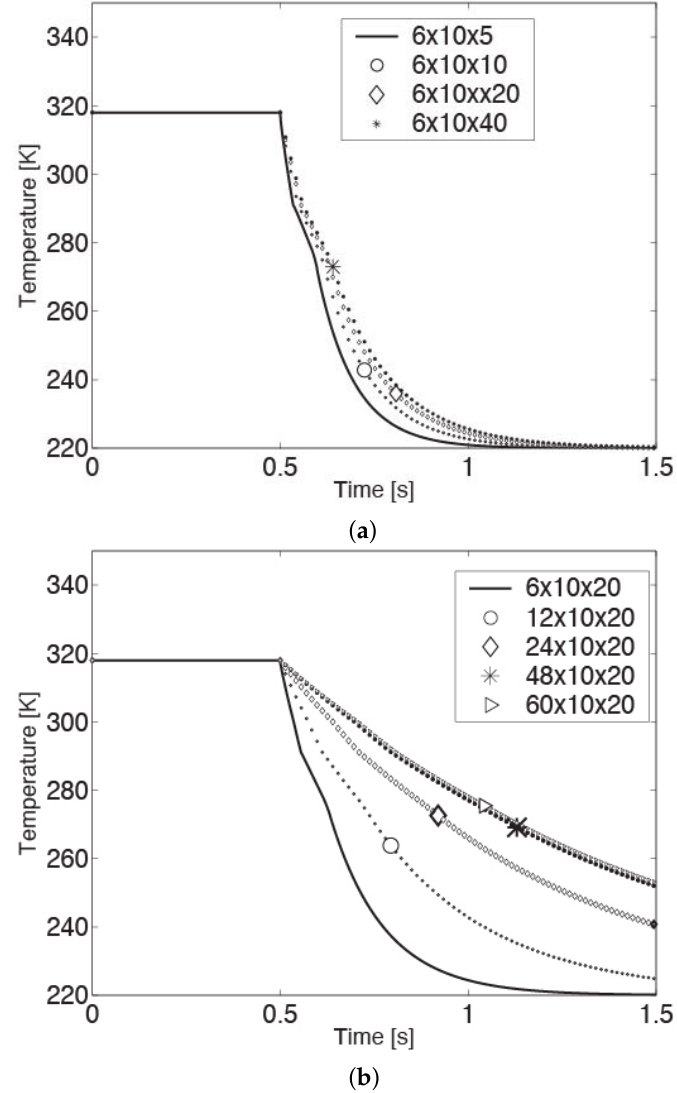
Figure 3. Mesh refinement along the ( a ) axial and ( b ) radian directions for a 100 micron droplet experiencing an ambient temperature and relative drop-gas velocity of 220 K and 20 cm/s,